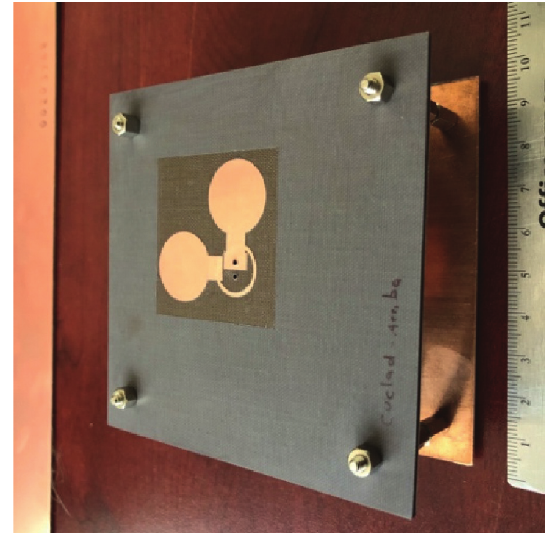
Figure 11: UCPA antenna.